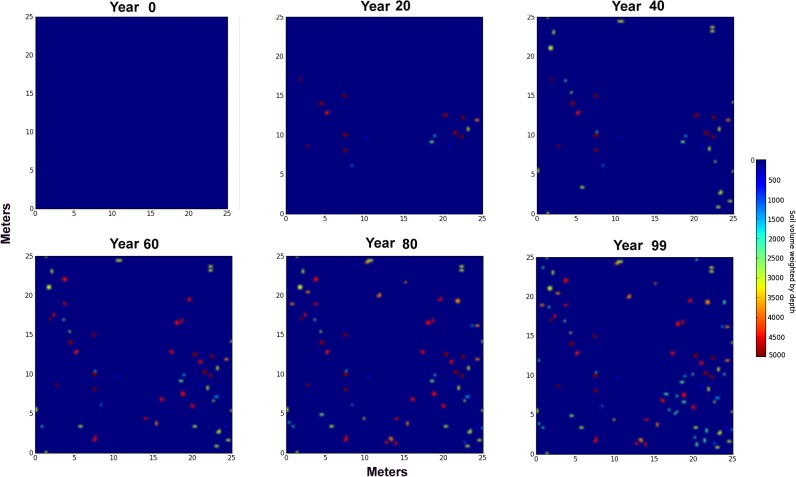
A representative simulation of disc locations of one colony in 625 m2.Increments of 20 years shown, with colors showing depth-weighted source of soil. This is the approximate natural density of colonies. Blue indicates a shallow source of soil, while red indicates admixture of deepest layers. Colonies move a mean of 4 m per year in random directions (see text for details).